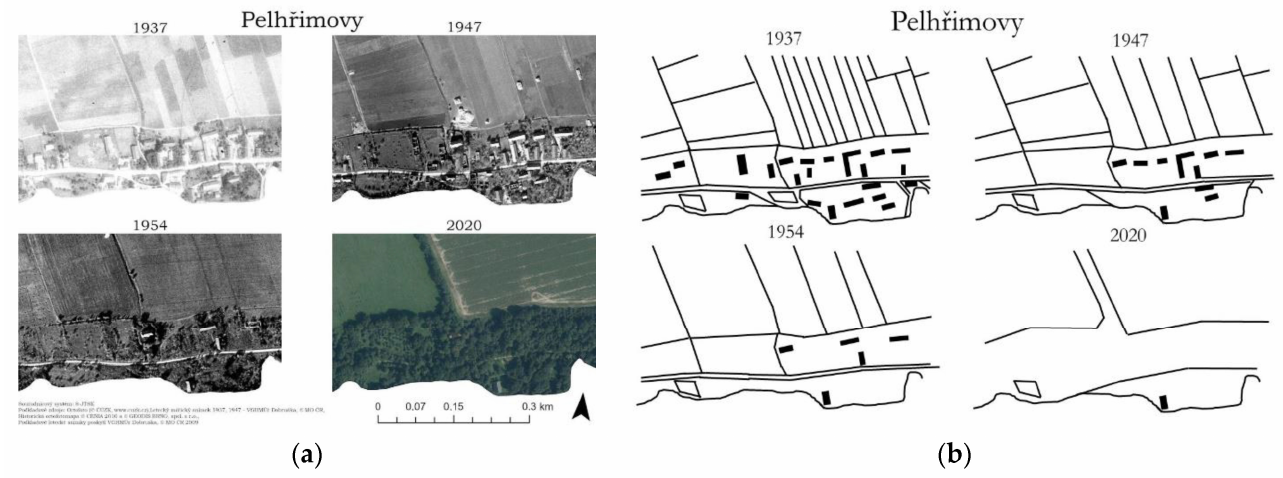
Figure 6. Graphic materials for a comparative presentation of the dynamics of ( a ) landscape structure; ( b ) landscape texture. Source: Ortofoto 2020 (© ˇC Ú ZK, www.cuzk.cz), image 1946—VGHM Ú ˇr Dobruška, © Ministry of Defense of the